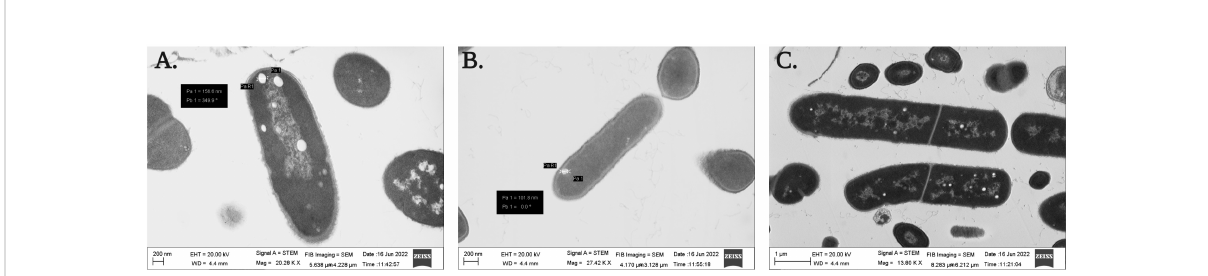
FIGURE 5 Transmission electron micrograph showing the formation of cytoplasmic inclusion bodies under salinity stress of (A) B. proteolyticus Cyn1, (B) B. safensis Cyn2, and (C)